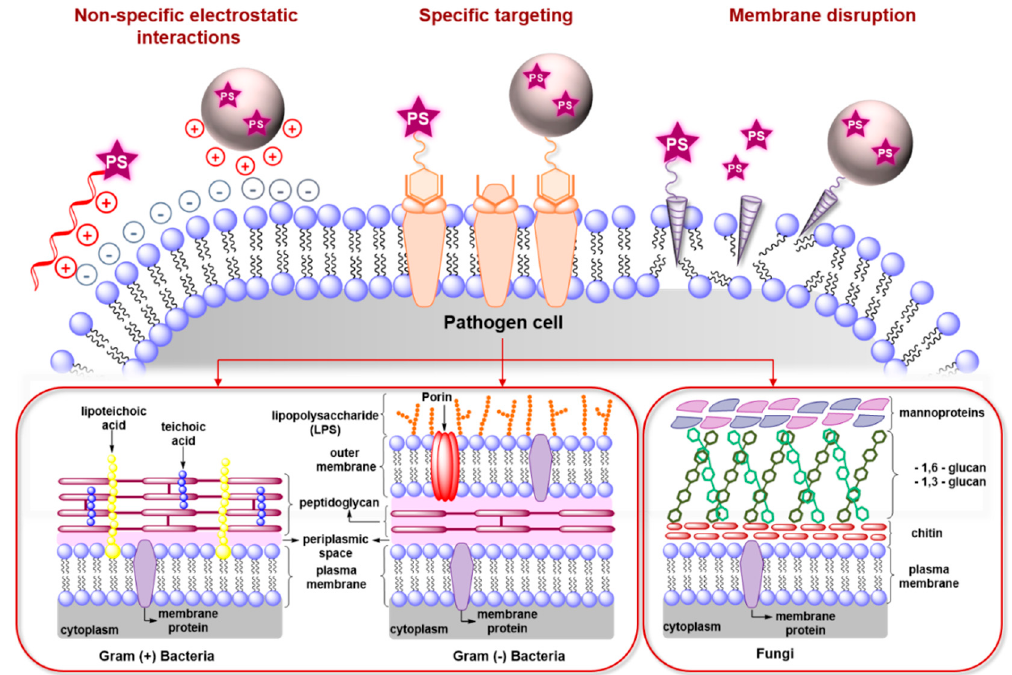
Figure 3. Different strategies applicable in the design of molecular or nano-PS targeted towards pathogens. The different designs involve the conjugation of non-specific poly-cationic materials, specific targeting ligands, or of membrane disrupting agents to known PS, either by direct conjugation to the chromophore, by using nano-carriers, or by co-administration. The lower section shows the differences between the surface of the main types of pathogens targeted by aPDT: Gram+ and Gram − bacteria and fungi.